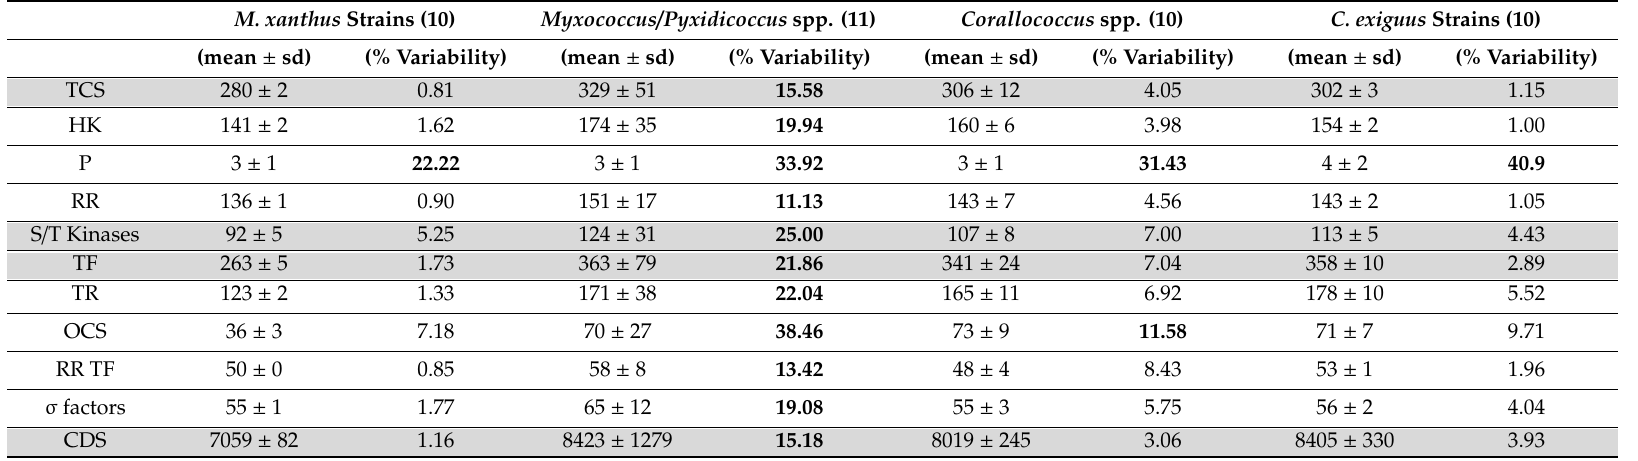
Table 2. Variability in the numbers of regulatory genes per genome. For each class of protein, the mean number ( ± standard deviation (sd)), and the variability coe ffi cient (standard deviation as a function of the mean) are presented, for four taxonomic groupings (the number of strains in each taxonomic grouping is indicated in parentheses). Variability coe ffi cients greater than 10% are in bold , and values for genome-wide numbers of CDS (protein coding sequences) are provided for comparison. Gray rows represent classes, while white rows are sub-classes of the class above. TCS (two-component system) and TF (transcription factor) proteins are subdivided into di ff erent sub-classes based on domain organisation. HK = histidine kinase, P = phosphotransfer protein, RR = response regulator, TR = transcriptional regulator, OCS = one-component